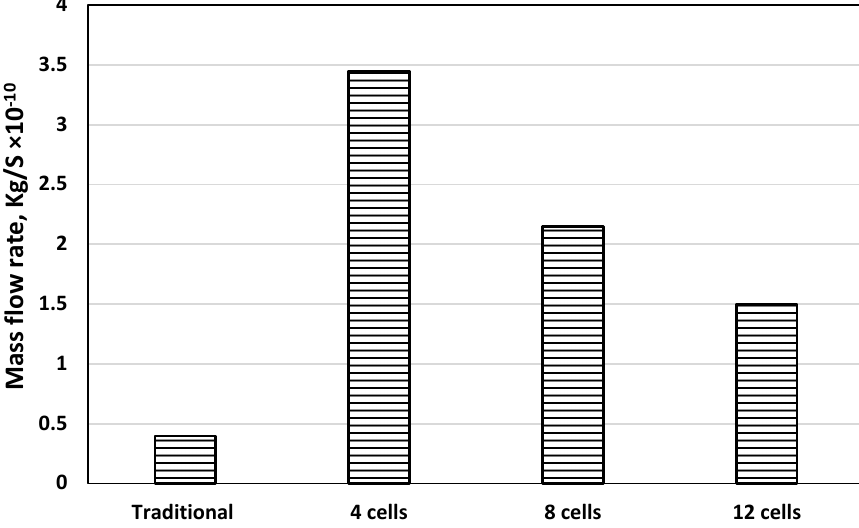
Figure 11. The mass flow rate of water vapor at the exit for different designs. 5.3. Current Density Distribution Figure 12 shows the current density distribution contour through the cell with differ- ent plans. The current distribution mainly concentrated on the current collector’s contact points with the cell. Therefore, having more contact points with the cell led to efficient current collection from the cell. This finding can explain the high performance of the de- veloped trapezoidal design with twelve channels. The current density distribution for the design with four channels was higher than the designs with eight and twelve channels. This finding was mainly due to the limited contact surface in the case of the four-channel design. Therefore, the current concentration was high. The designs with eight and twelve channels had almost the same current density distribution, as shown in Figure 12.